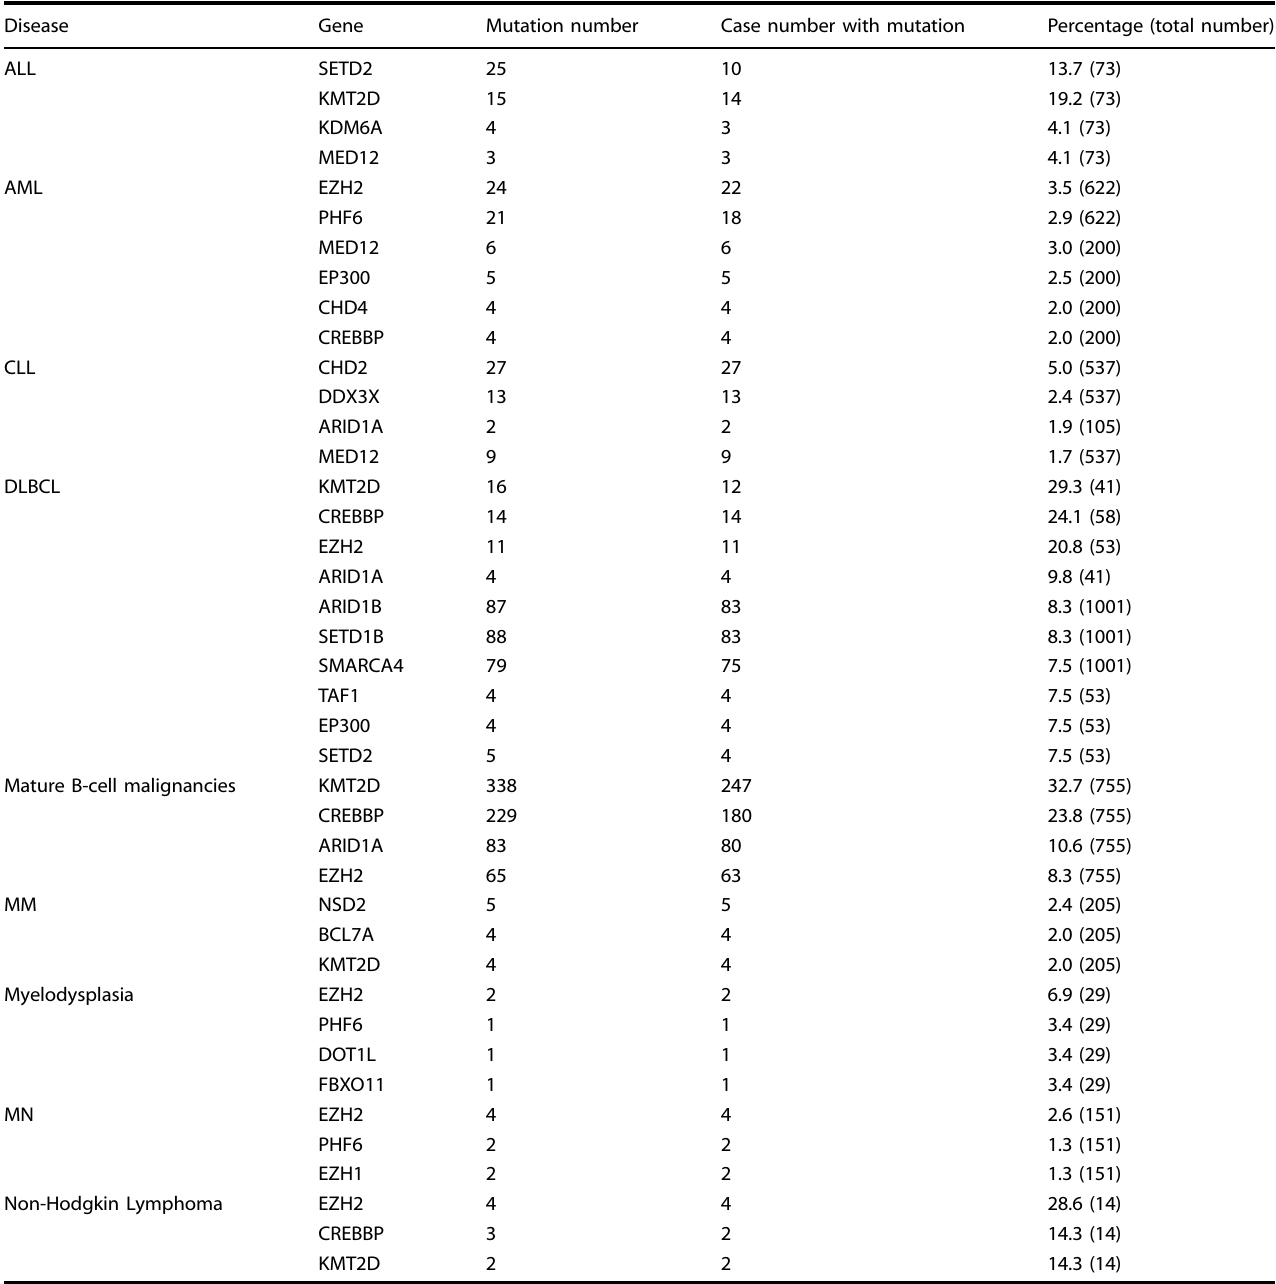
Table 2. Transcriptional cofactors with high frequency of mutations in hematological malignancies Disease Gene Mutation